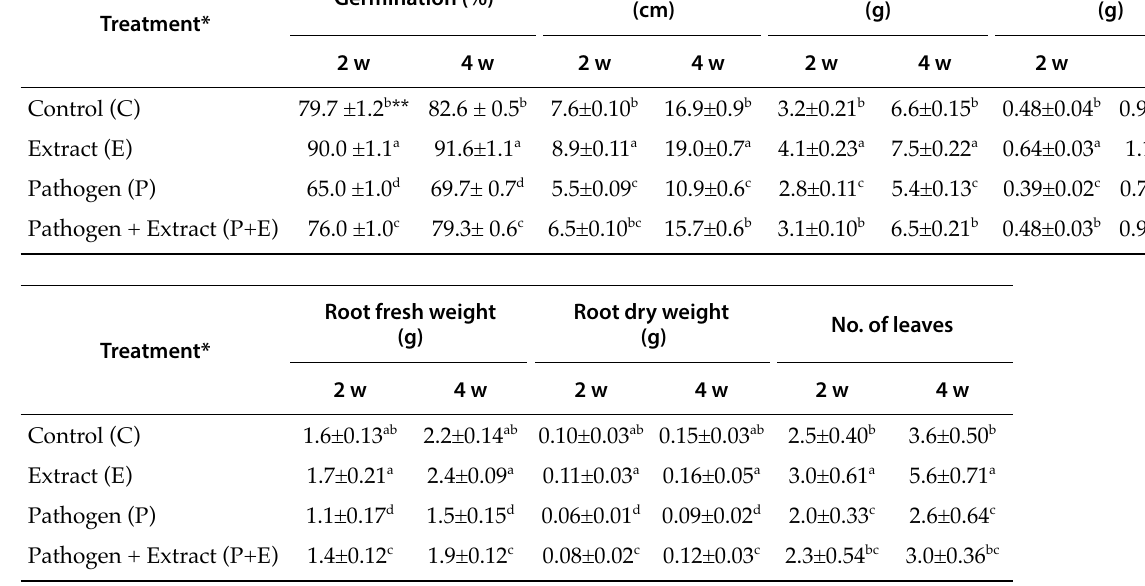
* Values are the means of fifteen replicates ±SE. ** Values of each column followed by the same letter are not significantly different according to Duncan’s multiple range test ( P ≤ 0.05). Table 5. Mean amounts of total phenol, and activities of peroxidase (POX) and phenylalanine ammonia-lyase (PAL) of sun- flower plants, the seedlings of which received different treatments of Fusarium solani inoculation and/or turmeric extract application, at 2 and 4 weeks after